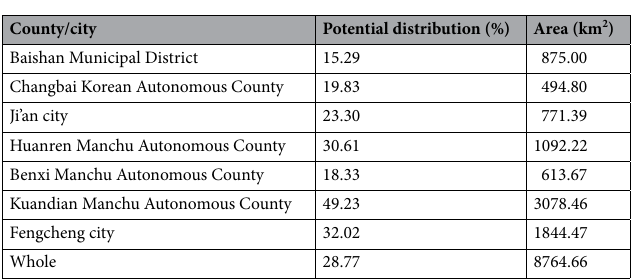
Figure 5. Potential distribution map of water deer generated by the ensemble SDMs and the range of nature reserves (orange areas with diagonal) in Northeast China. The purple points are the presence location of water deer, and the blue points are the absence location of the deer which was defined by current study. This map was generated with ArcGIS 10.7 (Environmental Systems Research Institute, Inc. in Redlands, California, USA. URL: https:// www. esri. com/ en- us/ arcgis/ produ cts/ arcgis- deskt op/ overv iew).